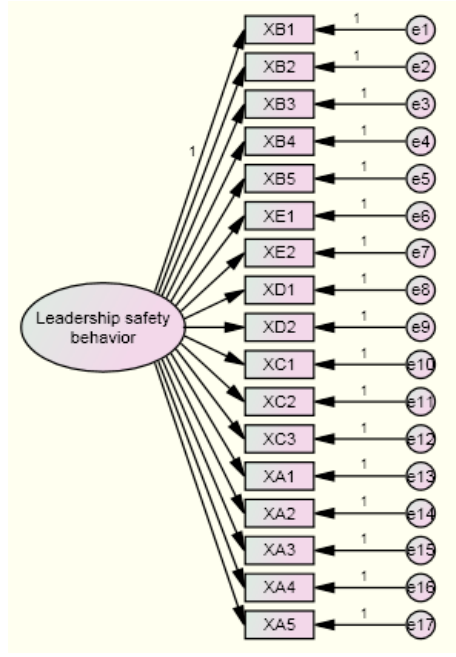
Figure 1. The single-factor structural model.